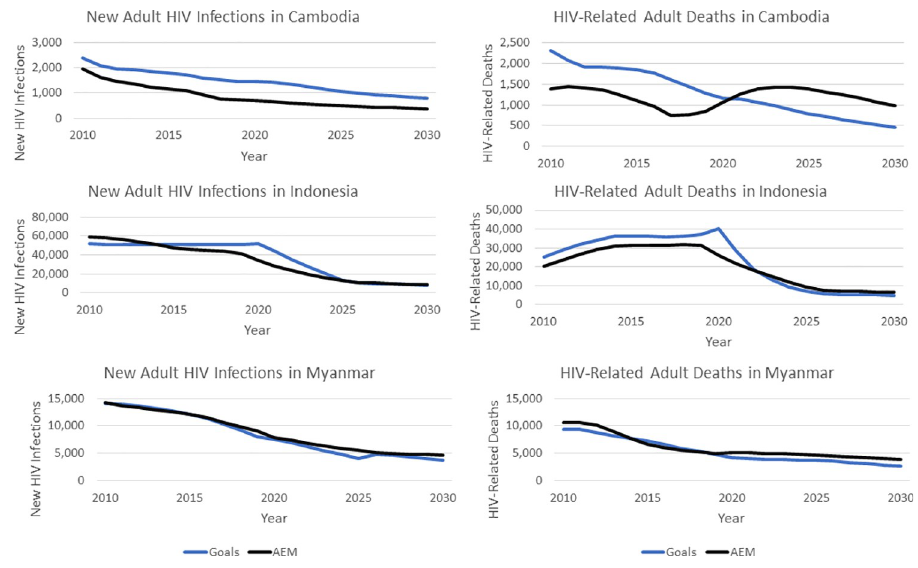
Fig 6. Comparison of AEM and goals results. AEM, AIDS Epidemic